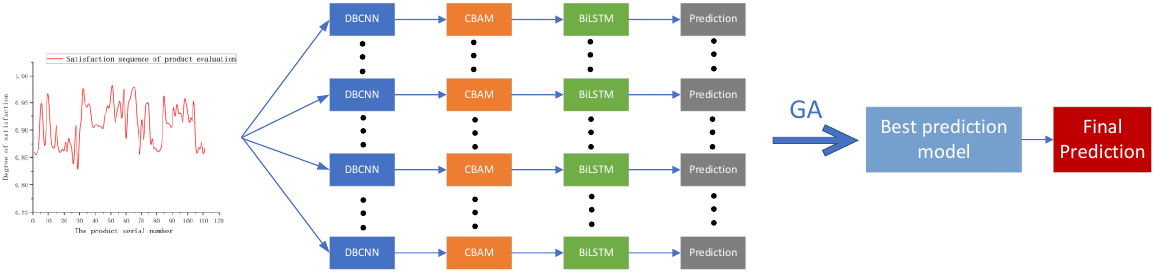
Figure 1. Using Genetic Algorithm (GA) to optimize Spatiotemporal correlation forecast model.